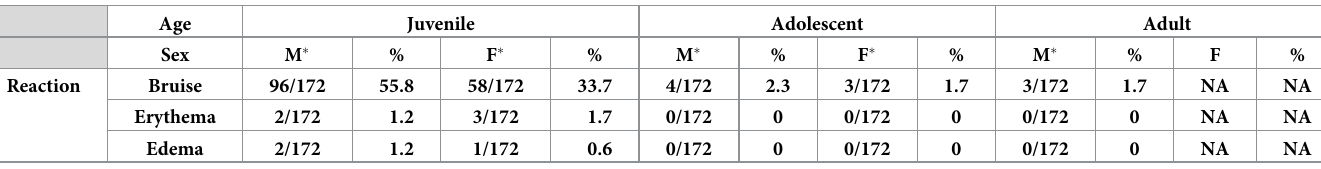
Table 2. The quantity and percent of TST reactions by age and